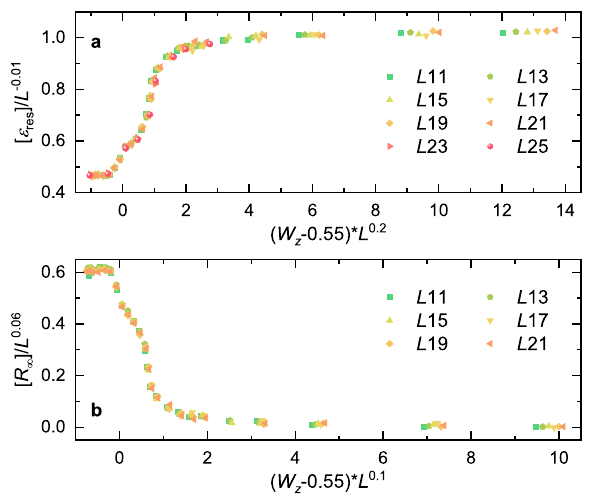
Fig. 8 Finite-size scaling analysis for cMBL-dMBL transition at = 1. The respective data collapse of random-averaged fi xed g x dynamic order parameters ½ ε res (cid:3) [panel a ] and [ R ∞ ] [panel b ] yields 0 : 55 W x . Here, PBCs are used; for consistently a critical W c z (cid:7) L = 23, 25, the results are extracted from the Krylov-typicality approach; other sizes are solved by ED.